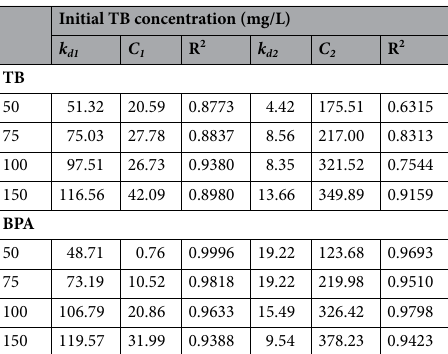
Figure 11. Intraparticle diffusion plots for removal of ( a ) TB, and ( b ) BPA, and Boyd plots for removal of ( c ) TB, and ( d ) BPA at initial concentrations using FGS2 sample [pH: 3, agitation speed: 300 rpm, and solution temperature: 25 °C]. Initial TB concentration